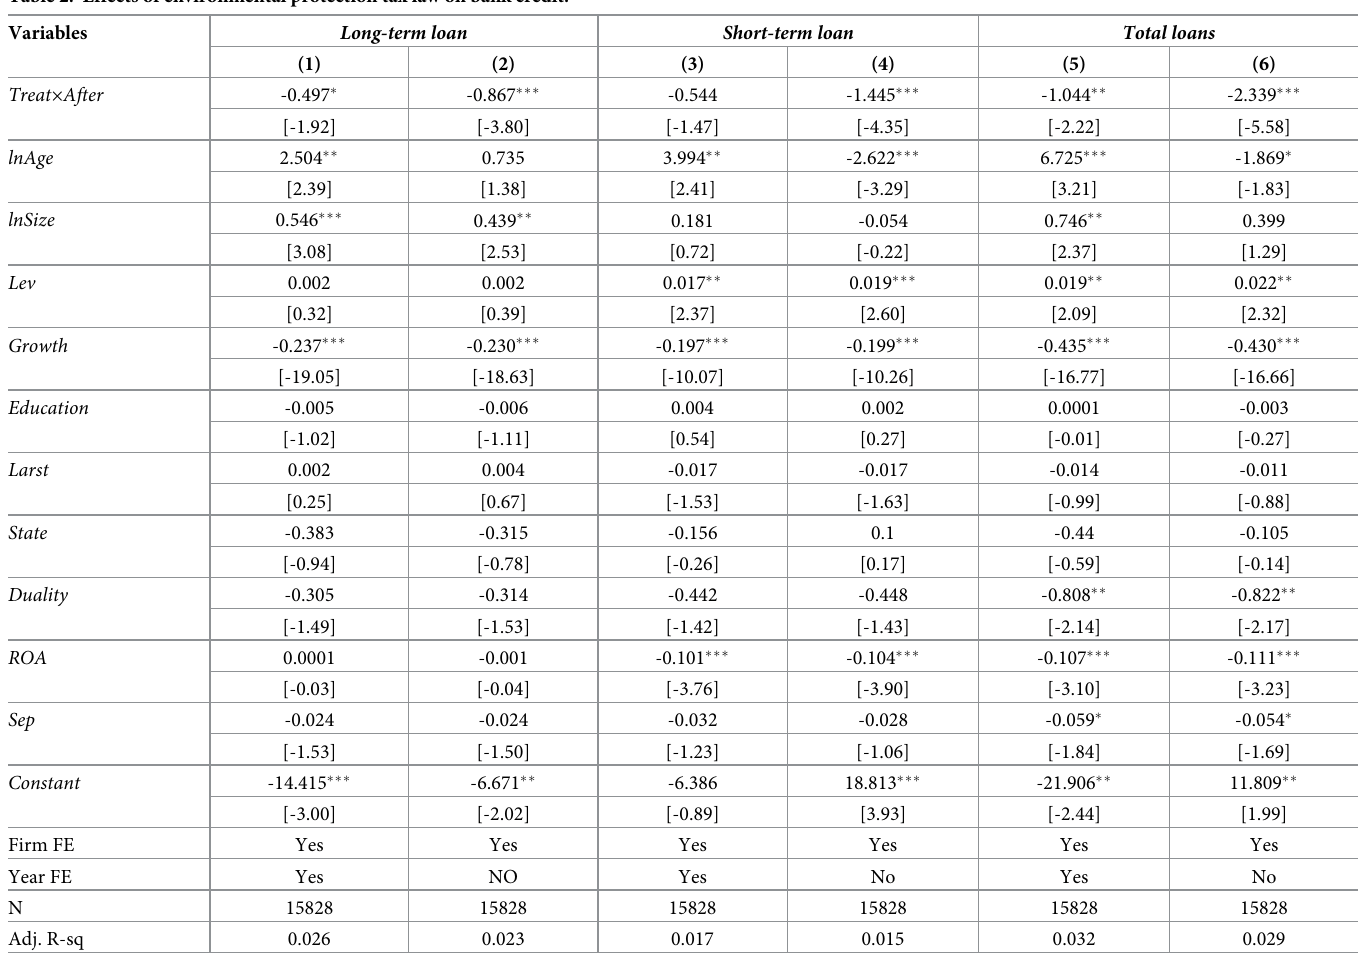
Table 2. Effects of environmental protection tax law on bank